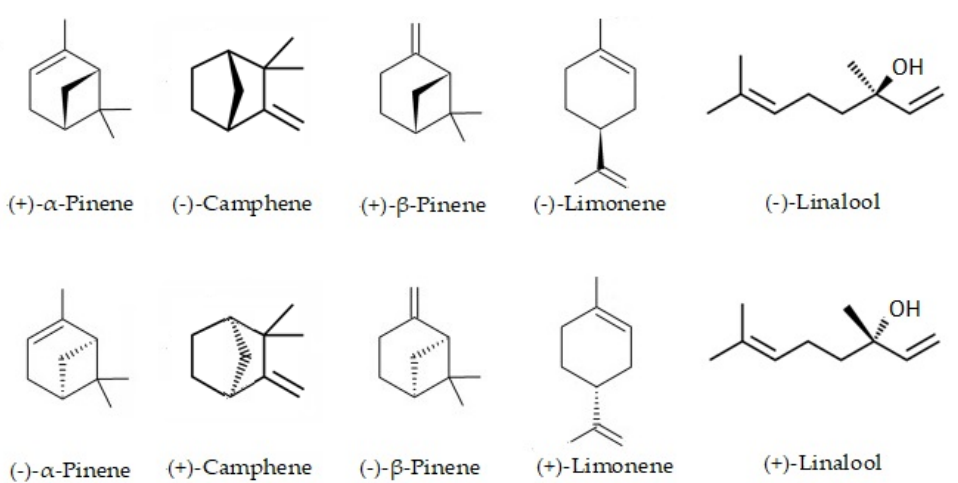
Figure 3. Chemical structures of the stereoisomers of the essential oil from leaves in fruits of Siparuna muricata . Table 3. Antimicrobial activity of essential oil from the leaves and fruits of Siparuna muricata .